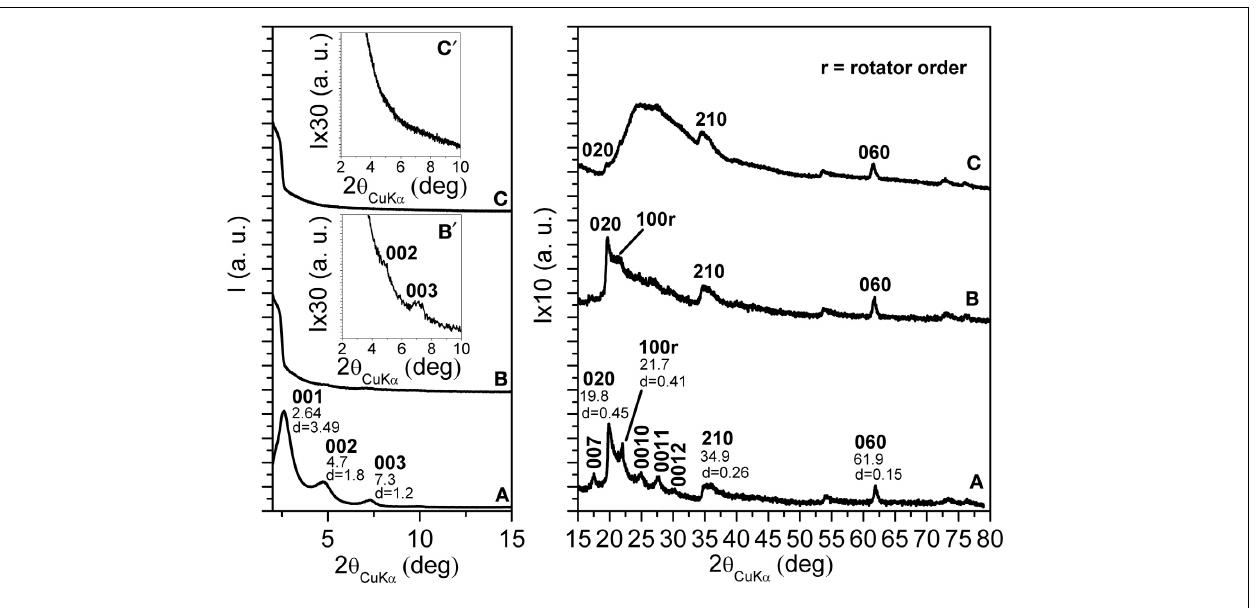
enlarges the 2 ϑ range 2–10 ◦ .The Miller index 100r indicate the reflection relative to the rotator order of the long hydrocarbon chains within the interlayer